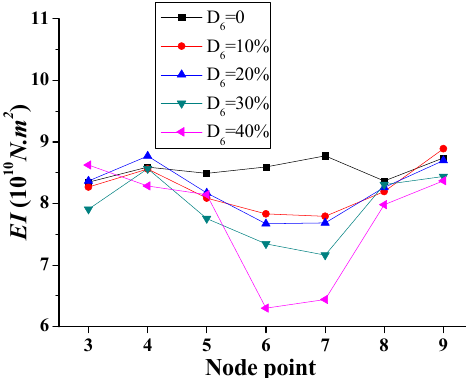
Figure 9. Simulation results of calculated EI for a single damage (Scenario 1).